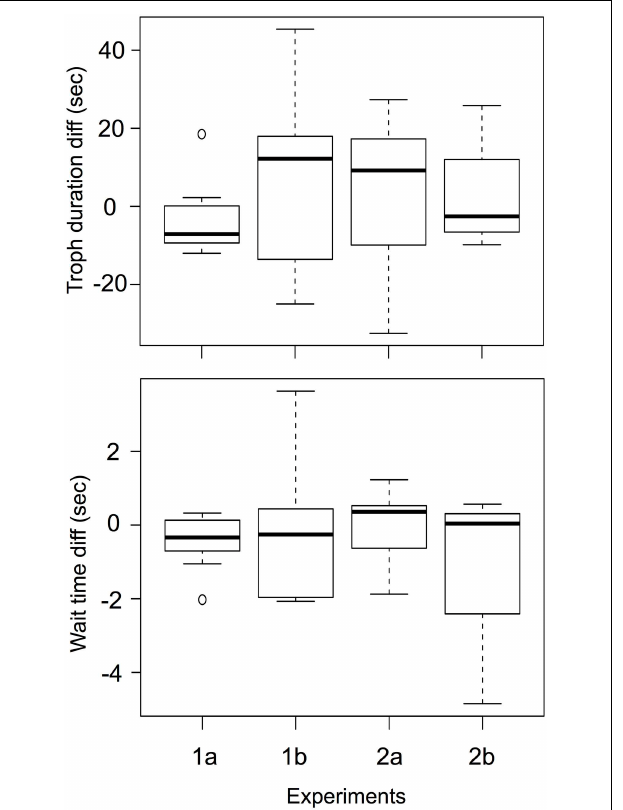
P-values are reported for a test of whether foragers experience a longer-than-average wait time (or shorter-than-average trophallaxis duration) on their last trip more often than expected by chance (exact binomial test).